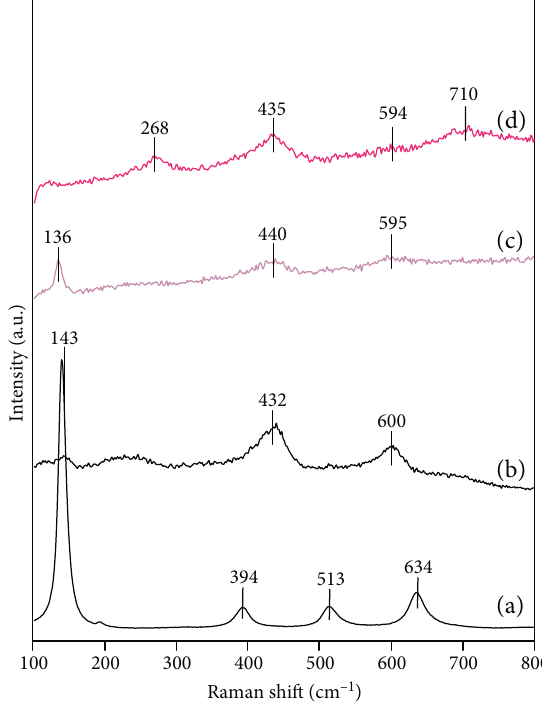
Figure 5: Raman spectra of (a) anatase (JRC-TIO-1), (b) rutile (JRC-TIO-16), (c) HTNO (0.1)_600, and (d) HTNO